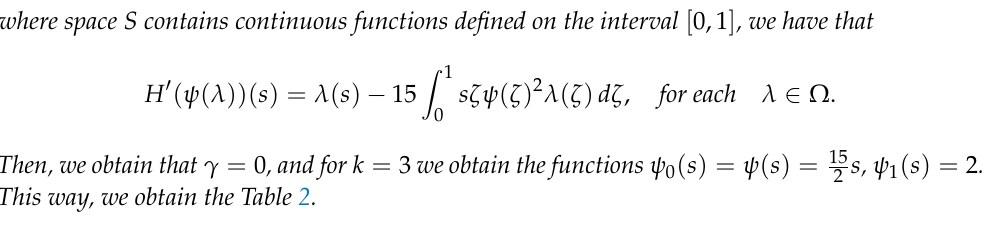
Table 2. Radius for Example 2.